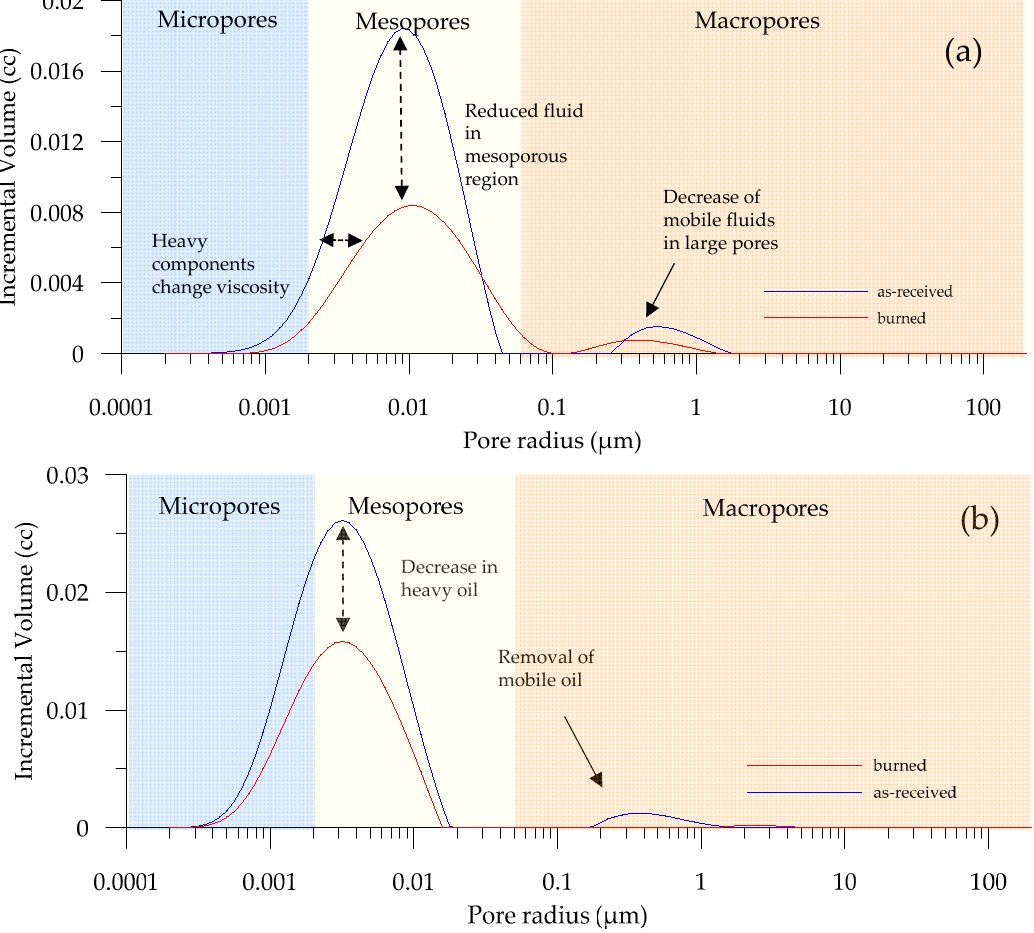
Figure 13. Pore size distribution for target samples ( a ) #2, CT section; ( b ) #12, CT section Table 7. Results of NMR T 1 –T 2 interpretation for target samples before and after